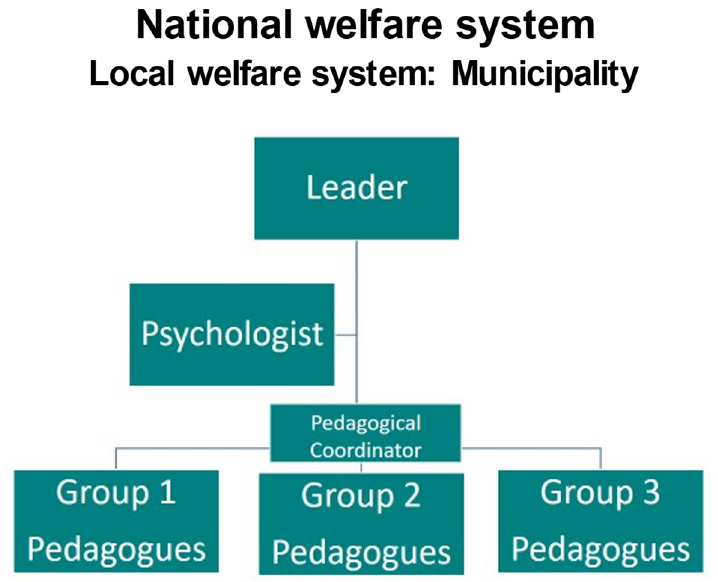
Figure 1. Internal organization of the institution within the national and local child protection sys- tem.